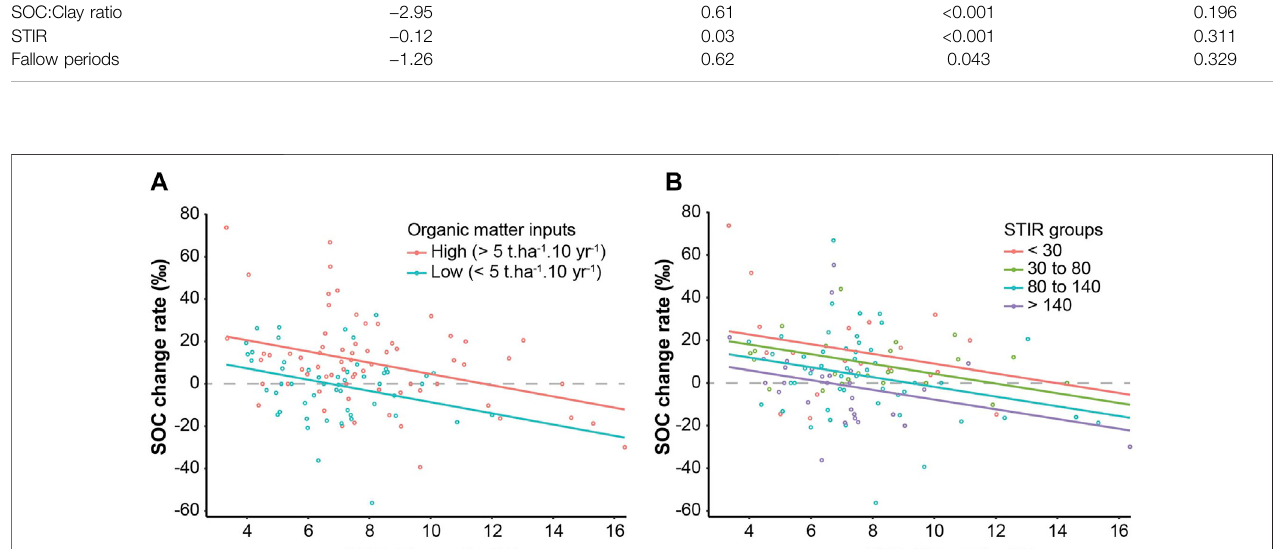
FIGURE 4 | Panel (A) Linear relationships between annual rate of change in soil organic carbon content (SOC) and SOC:Clay ratio for “ low ” ( < 5 t ha − 1 y − 1 ) and “ high ” ( > 5 t ha − 1 y − 1 ) organic matter input categories with constant slope ( − 2.65). Panel (B) Linear relationships between annual rate of change in soil organic carbon content (SOC) and SOC:Clay ratio for soil tillage intensity (STIR) categories with constant slope ( − 2.28). Linear Intercepts, R 2 and p -values (for slope and intercept) of each group can be found in Supplementary Table S3